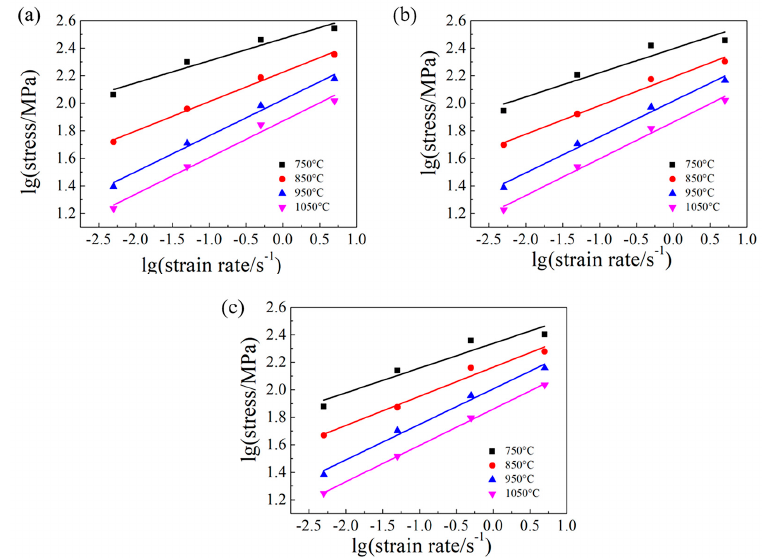
Table 1. Flow stresses of Ti555211 sample on various deformation conditions (MPa). ε  ε /s − 1